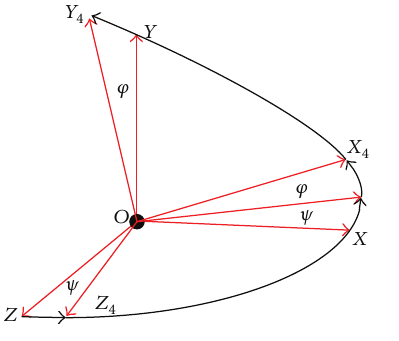
Figure 9: Coordinate conversion from 𝑂𝑥𝑦𝑧 to 𝑂 󸀠 𝑥 4 𝑦 4 𝑧 4